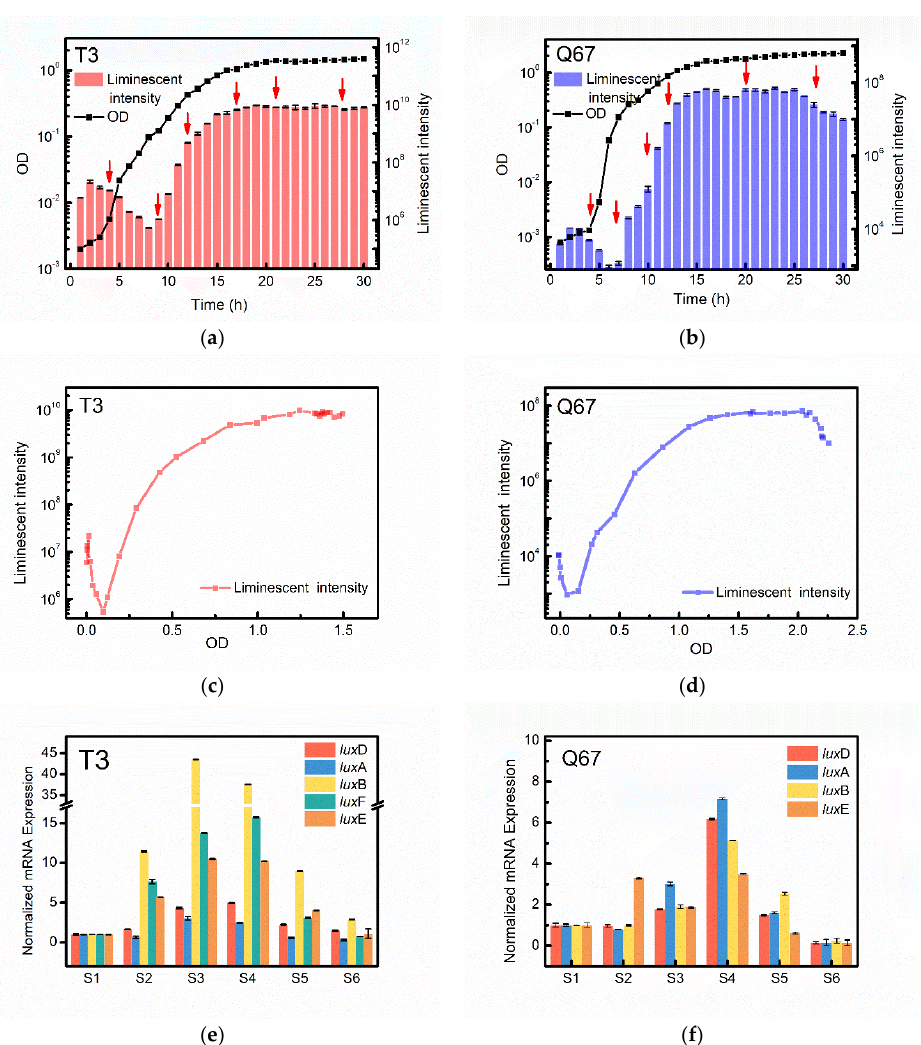
Figure 2. Bioluminescence and lux gene ‐ expression levels of T3 and Q67 throughout the growth phases. ( a , b ) Growth and bioluminescence kinetics of T3 and Q67. Red arrows represent the sampling times S1 to S6. ( c , d ) Light emission of T3 and Q67 according to cell density. ( e , f ) Expression level of the lux DAB(F)E genes in T3 and Q67 for sampling times S1 ‐ S6. From the study on the variations of bioluminescence and the light ‐ emission ‐ involved gene expression of the T3 and Q67, the results showed that the bioluminescence of the two strains was population density ‐ dependent. It is evident that the two bacteria are quorum ‐ sensing controlled.